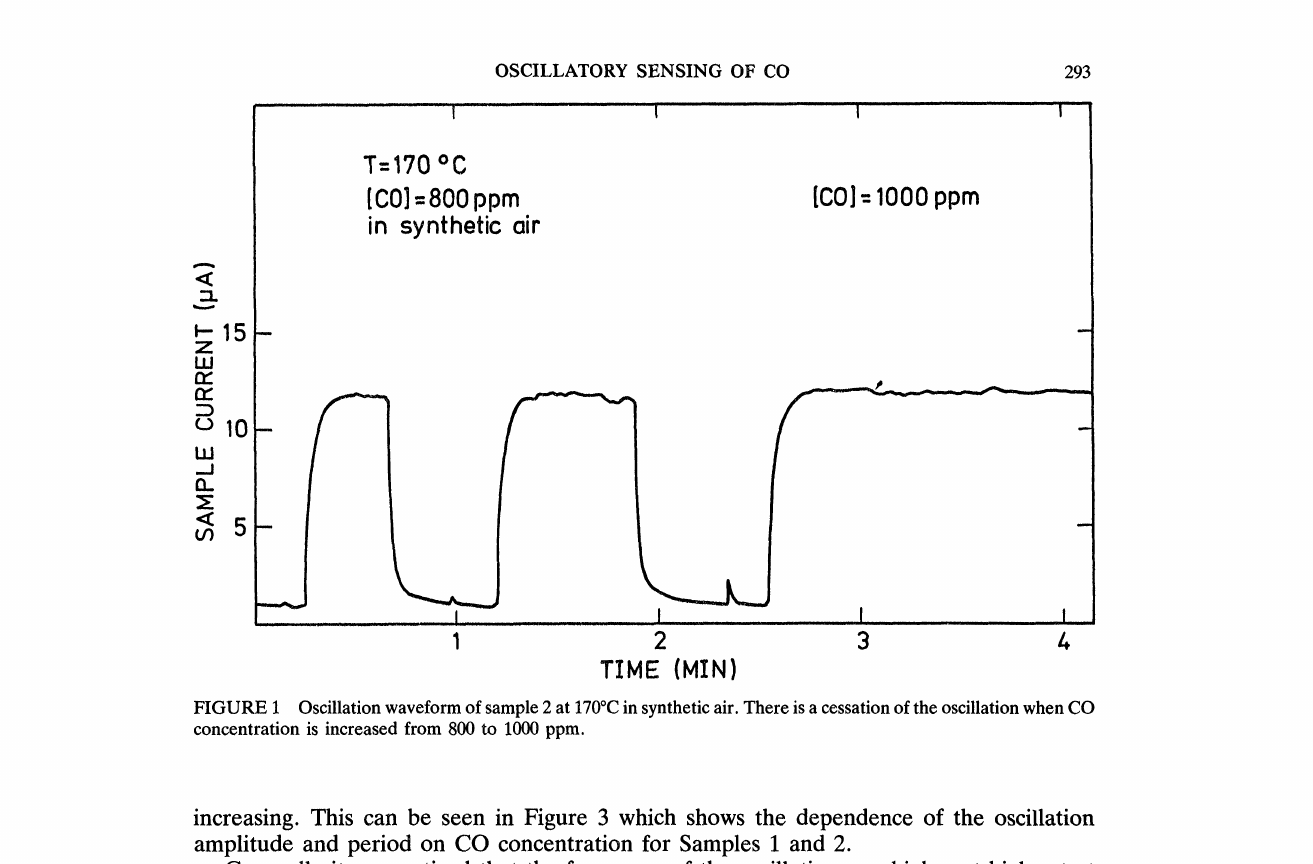
Oscillation waveform of sample 2 at 170C in synthetic air. There is a cessation of the oscillation when CO concentration is increased from 800 to 1000